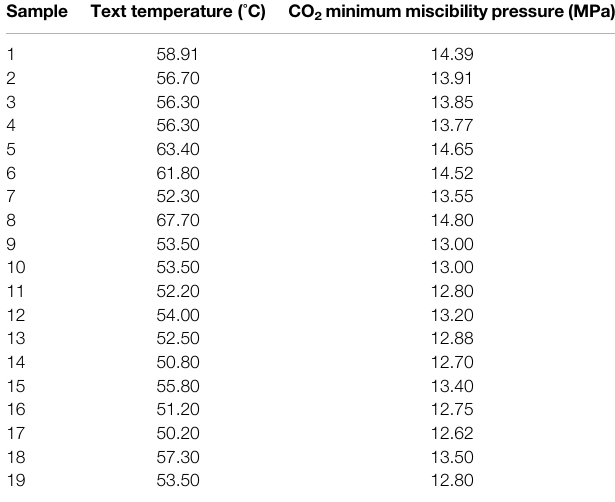
TABLE 3 | Test results of the slim tube of CO 2 minimum miscibility pressure for